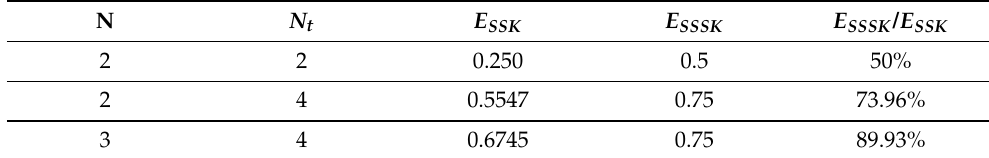
Table 3. Comparison of RF-switching